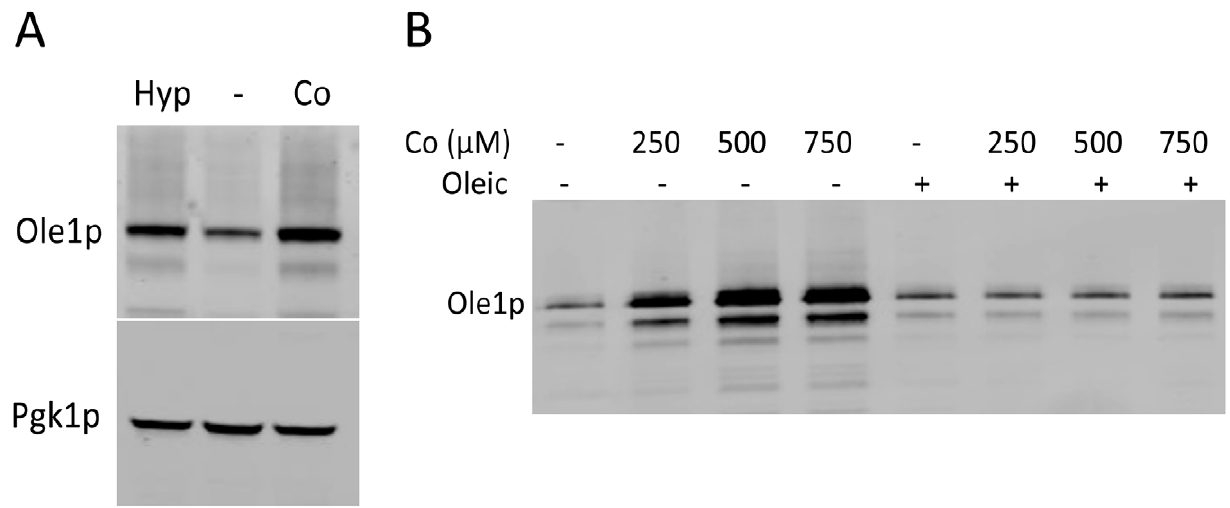
Figure 6. Effects of cobalt and hypoxia on Ole1p. Immunoblot analysis was conducted as in Fig. 2B of cells expressing the TAP tagged version of Ole1p grown either in (A) minimal medium as in Fig. 1 or in (B) enriched medium as in Fig. 3 and supplemented with the indicated concentrations of CoCl 2 . Oleic: + , cells supplemented with 0.5 mM oleic acid. Results are representative of two (part A) or three (part B) experimental trials.